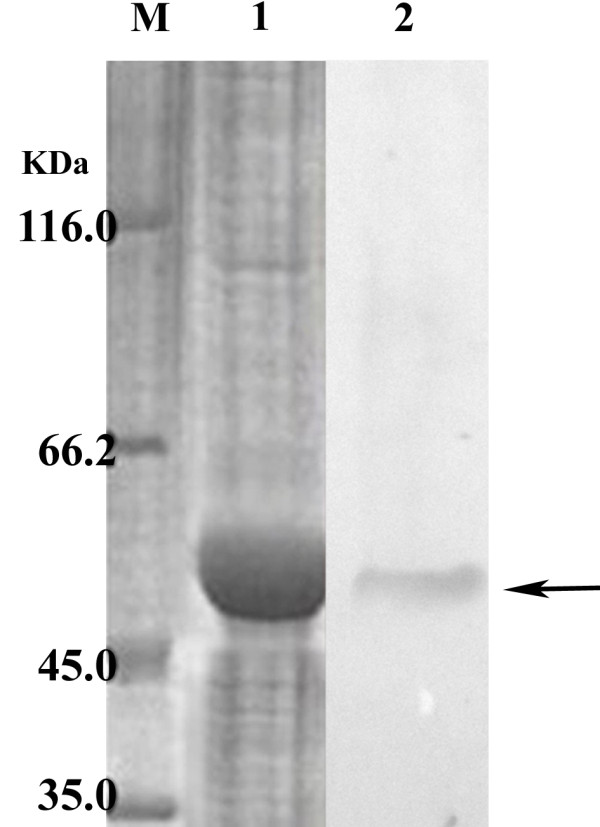
Western blotting analysis of recombinant proteins. M, protein marker; lane 1, purified recombinant proteins; lane 2, Western blot results.